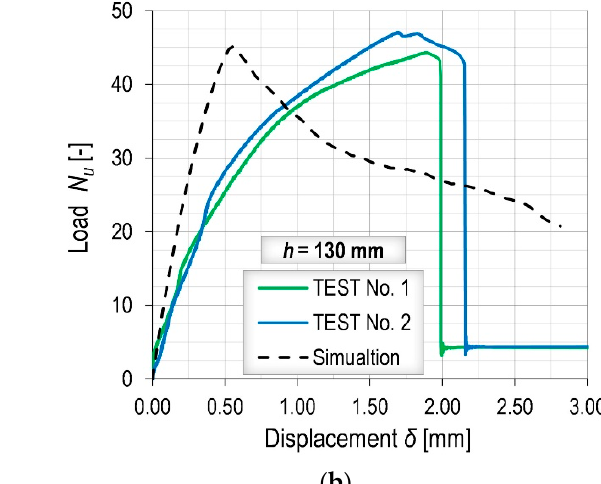
Table 4. Comparison between experimental and numerical results—plain concrete slabs.